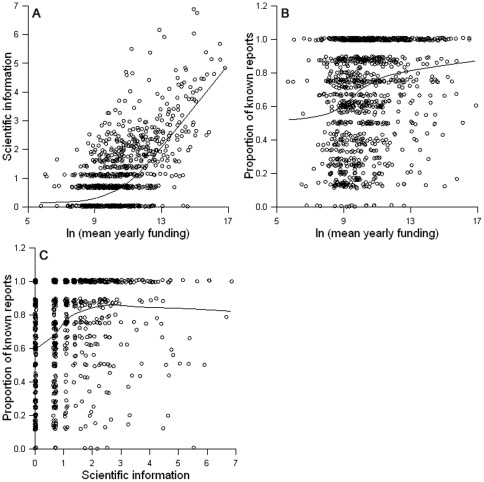
Relationships between funding, scientific information and the proportion of known reports.Scatter plots showing the relationship between (a) mean yearly funding and the amount of peer-reviewed scientific information available on a species, (b) mean yearly funding and the proportion of known reports and (c) amount of peer-reviewed scientific information and the proportion of known reports. Peer-reviewed scientific information is calculated as the number of Web of Science search conducted in July of 2007 of each species' scientific name. Mean yearly funding and peer-reviewed scientific information are natural logarithm transformed. Lines on the graphs show LOWESS smoothing functions with tension = 0.7. N = 1169.